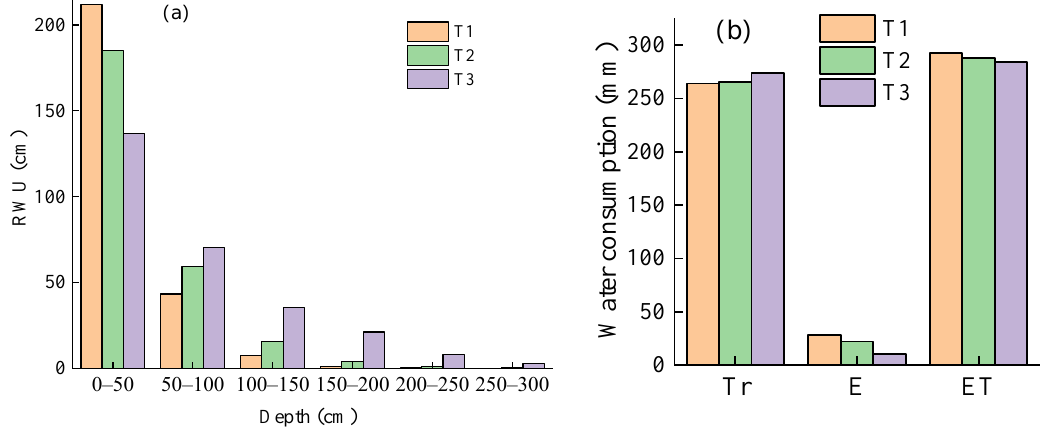
Figure 6. The comparison of the total RWU of winter wheat in different soil layers ( a ) and the water consumption composition of winter wheat ( b ) at different soil depths irrigation. Tr is the transpiration of winter wheat, E is the evaporation of winter wheat, and ET is the evapotranspiration of winter wheat.